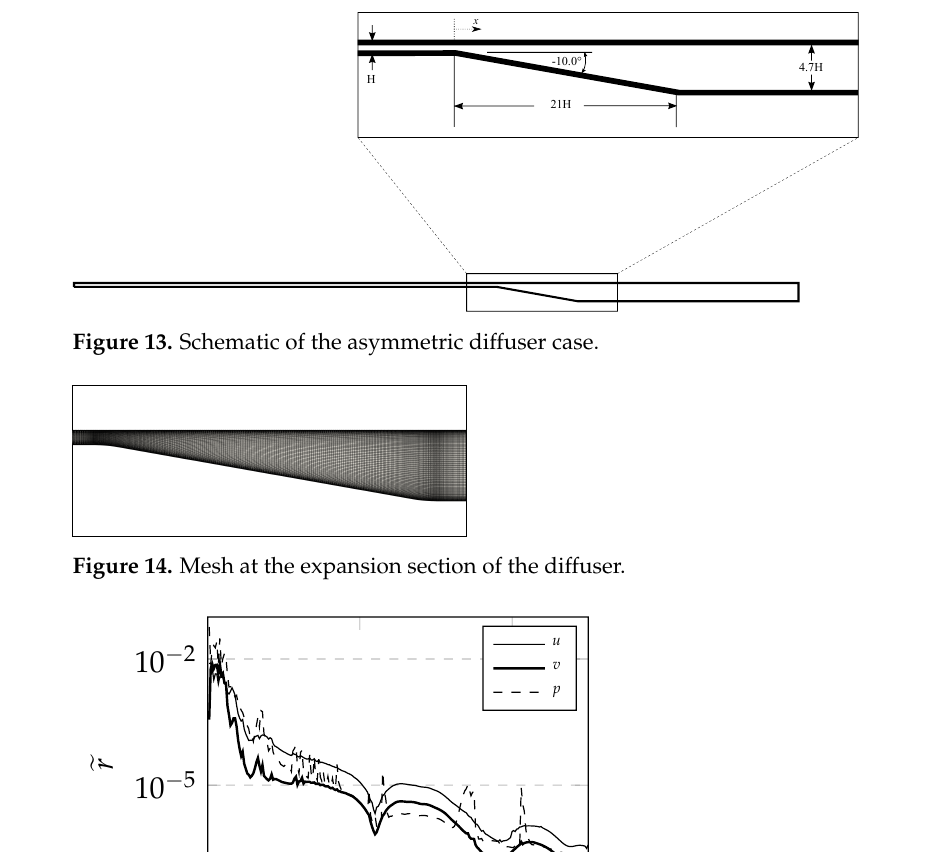
Version April 28, 2022 submitted to Appl. Sci.